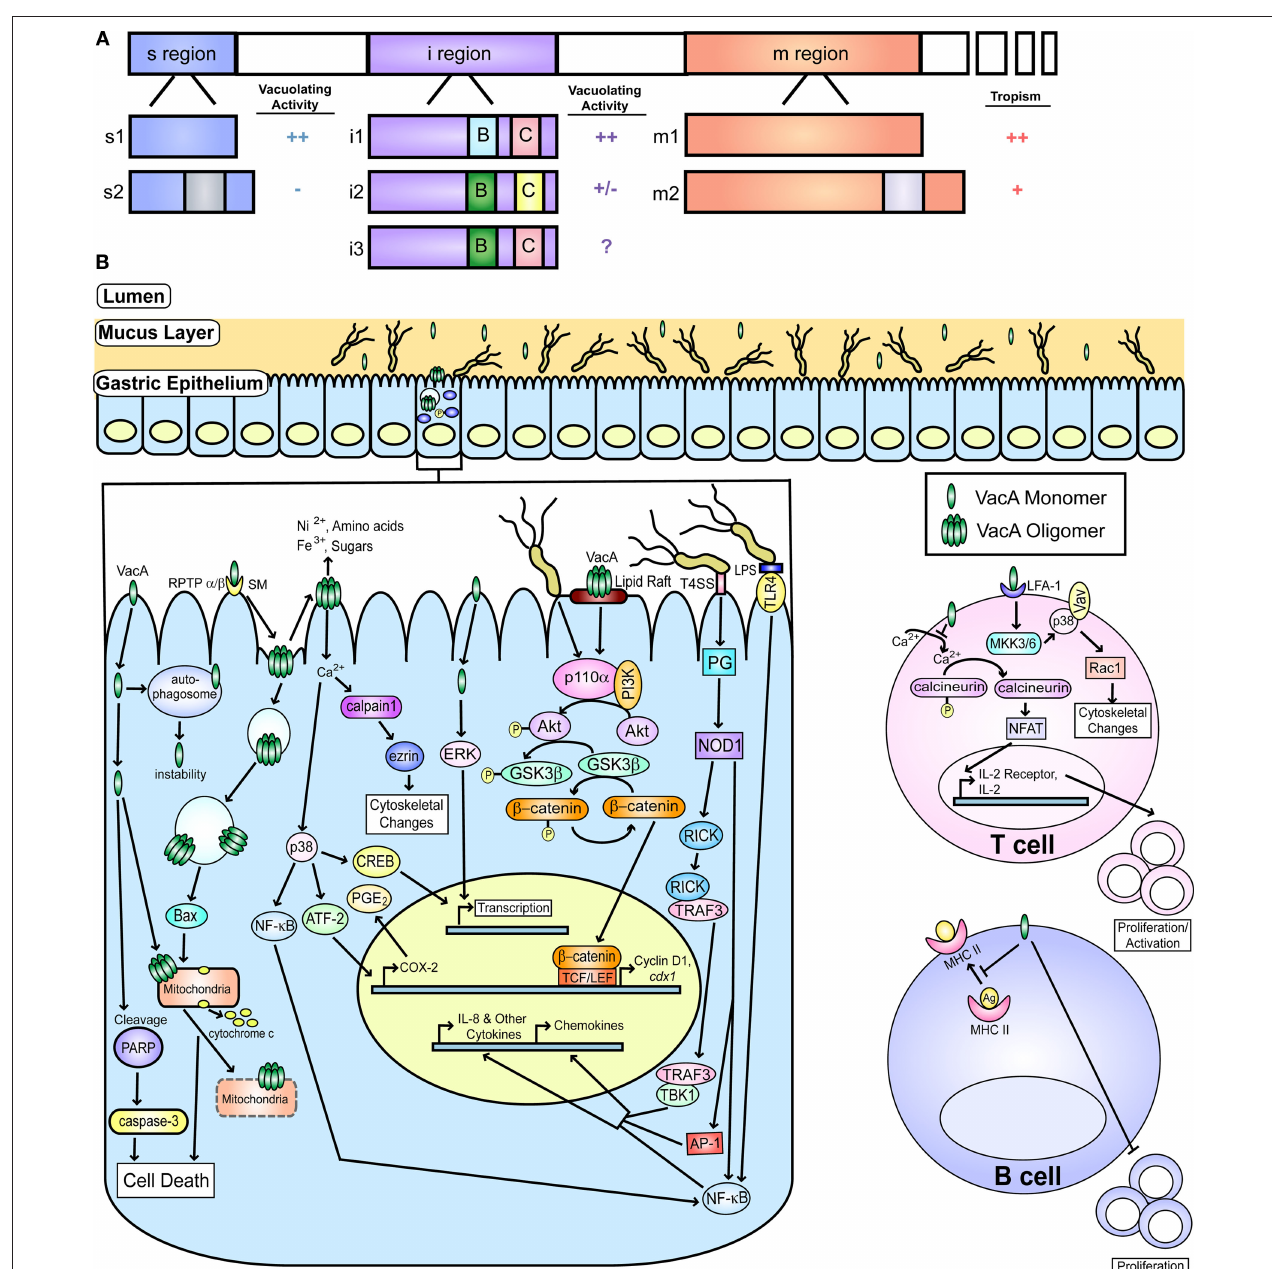
Figure 2 | VacA and known host cell targets. (A) A schematic representation of VacA with the three major regions of polymorphisms (s, i, and m) is shown. Additionally, schematics of the known alleles of each region are shown. The i region contains two important polymorphic regions known as Cluster B and Cluster C, which are designated by a B and C, respectively on the diagram. The activity attributed to each of the regions of the toxin (vacuolating activity or cellular tropism) are indicated, and the impact of each allele on these effects is shown. The highest level of activity or the broadest